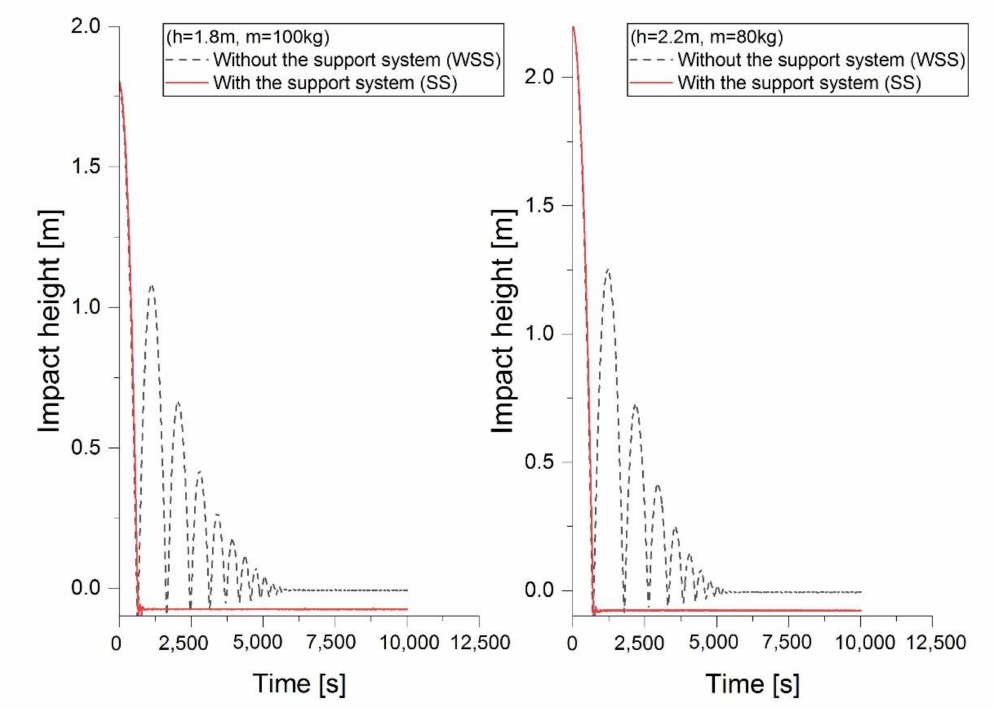
Figure 4. Time course of the drop hammer impacts with a final